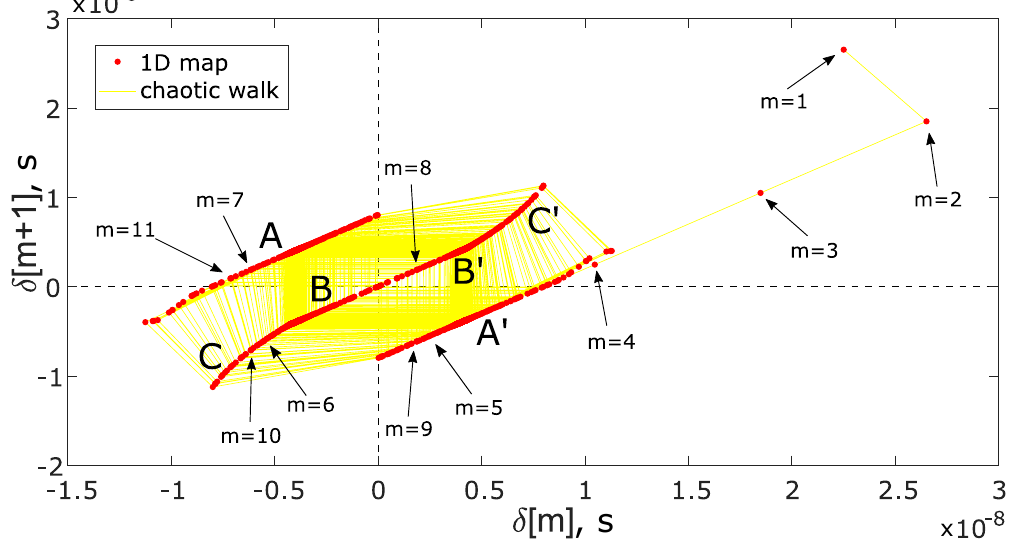
Figure 3. Example chaotic map of δ [ m ] with a few initial steps ( m ).